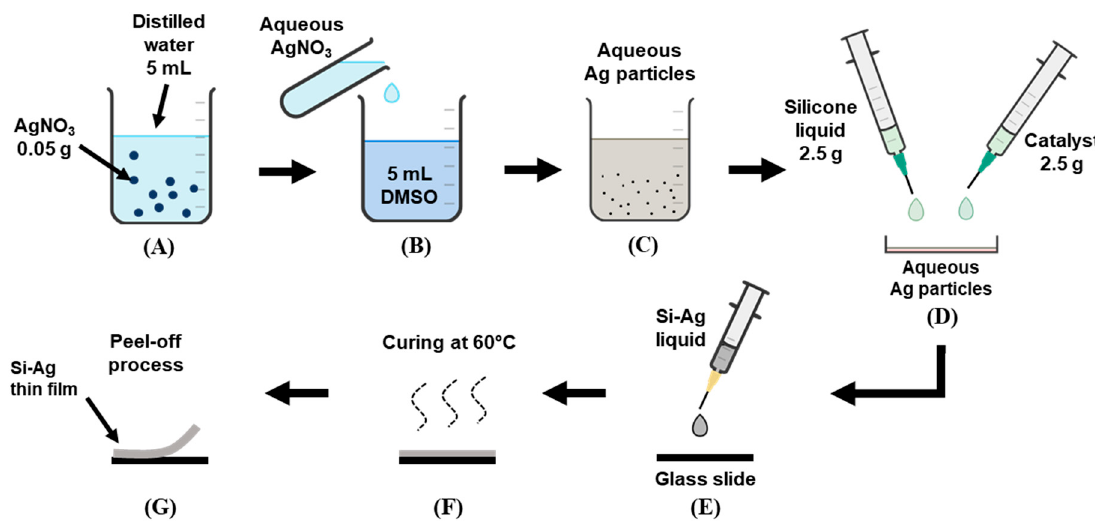
Figure 1. Illustration of the procedure for ( A – C ) the synthesis of Ag particles and the fabrication of Si–Ag thin films. ( D ) Si liquid and catalyst were mixed with aqueous Ag particles and ( E ) dropped onto the glass slide. ( F ) The curing process of Si–Ag liquid in oven and ( G ) peeled off of the fabricated film.